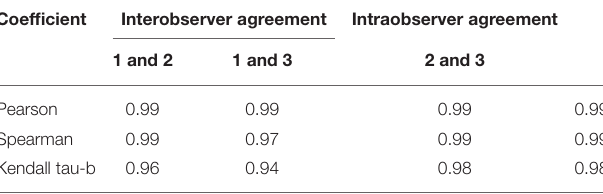
TABLE 2 | Interobserver and intraobserver correlation coefficient.